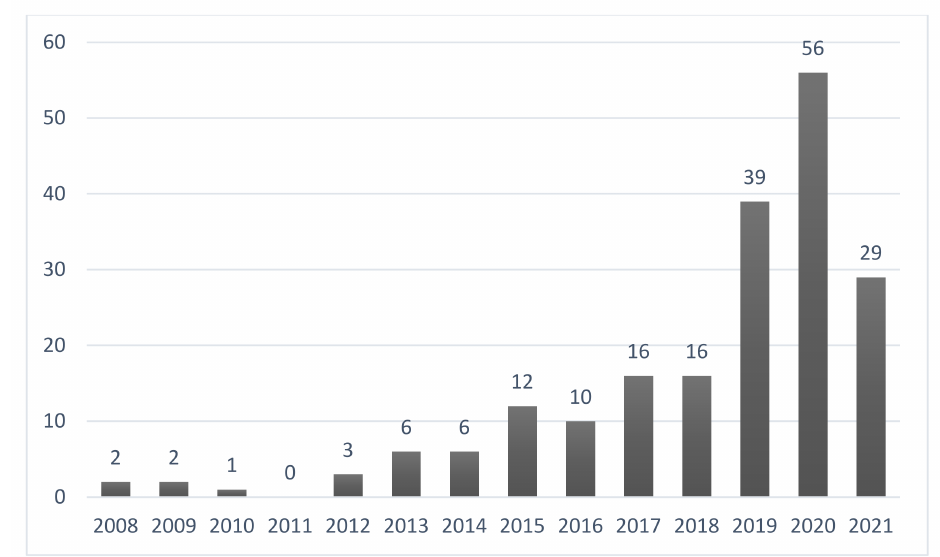
Figure 3. Number of Annual Publications